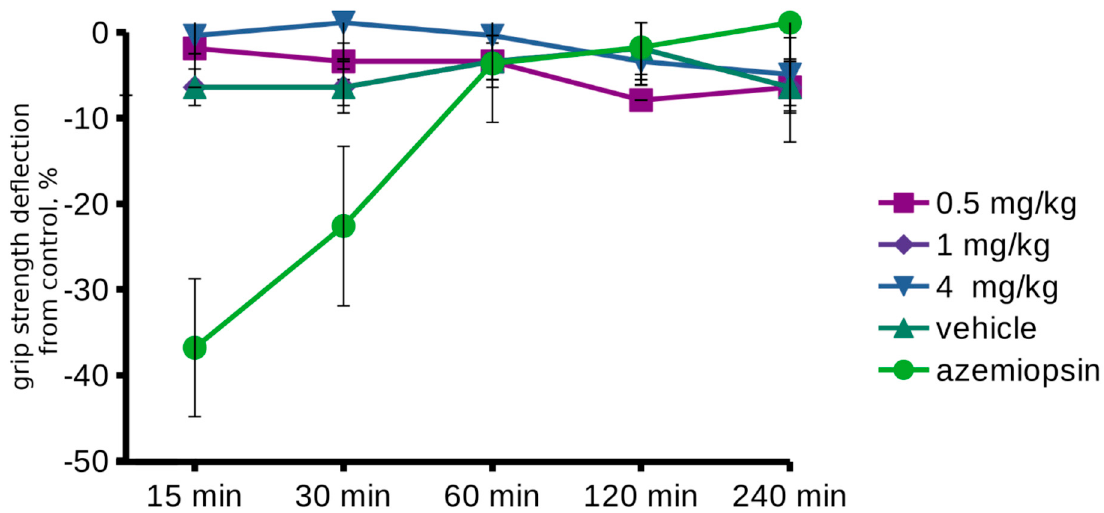
Figure 4. Evaluation of the AA-CHOL muscle relaxant activity in mice grip strength measurements. AA-CHOL intramuscular injection in various doses does not produce a significant muscle relaxation. In contrast, azemiopsin at 0.1 mg / kg shows significant (ANOVA, p < 0.05) muscle relaxation (green line, circles) at 15 and 30 min.